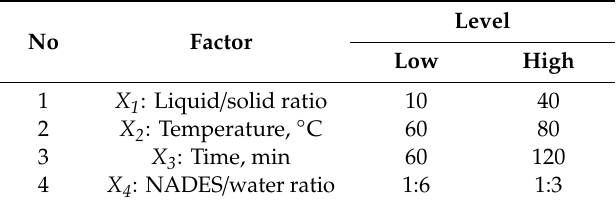
Table 1. Definitive screening design input for factors a ff ecting pectin extraction. NADES—natural deep eutectic